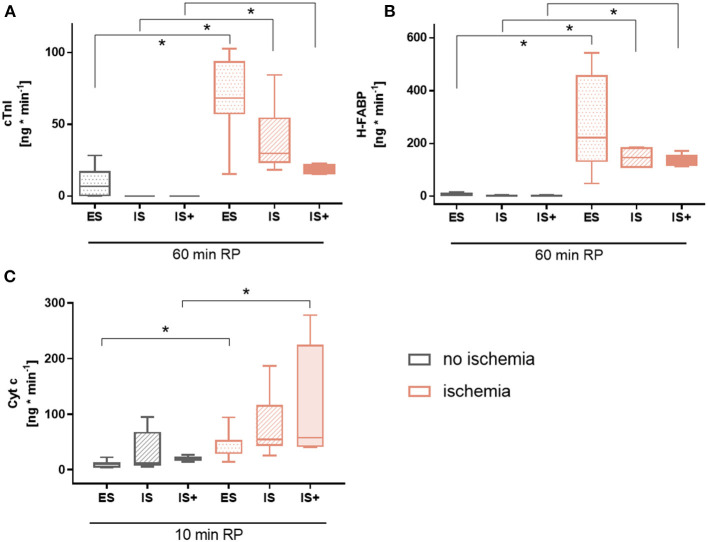
Circulating factors. (A) Cardiac troponin I (cTnI) release at 60 min reperfusion (B) Heart-type fatty acid binding protein (H-FABP) release at 60 min reperfusion (C) Cytochrome c (Cyt c) release at 10 min reperfusion. Data are expressed as median, 25–75 percentiles and range. *p < 0.05. ES, ex-situ model; IS, in-situ model; IS+, in-situ model with cardioplegia; RP, reperfusion; n = 5–8 per group.